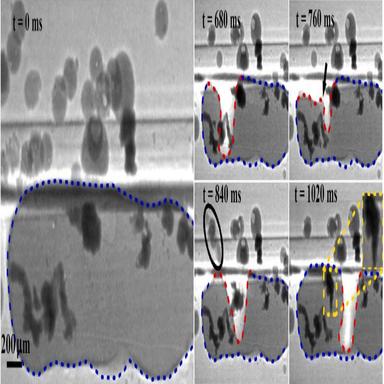
In situ XCT of a second remelting pass of the previously solidified W20(CoCrFeMnNi)80 mixture. (For interpretation of the references to colour in this figure legend, the reader is referred to the web version of this article.)